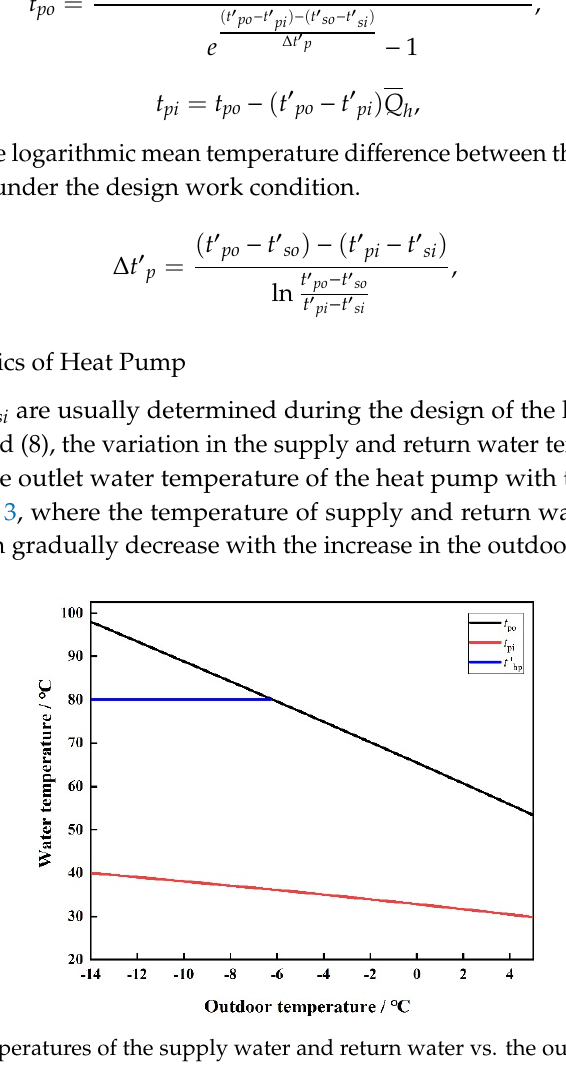
Figure 4. The relationship between the heating load and the outdoor temperature.